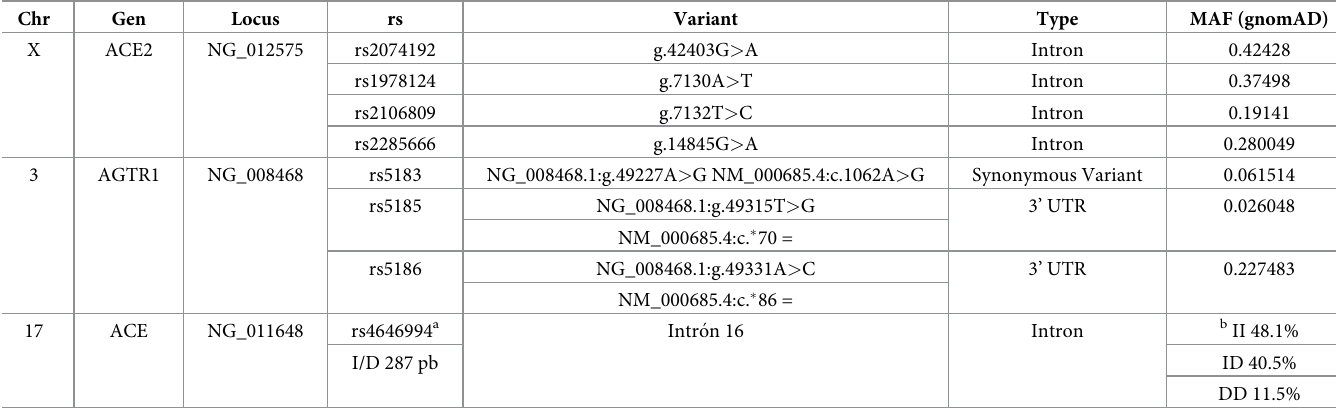
Table 1. Different SNPs of renin-angiotensin system included in this